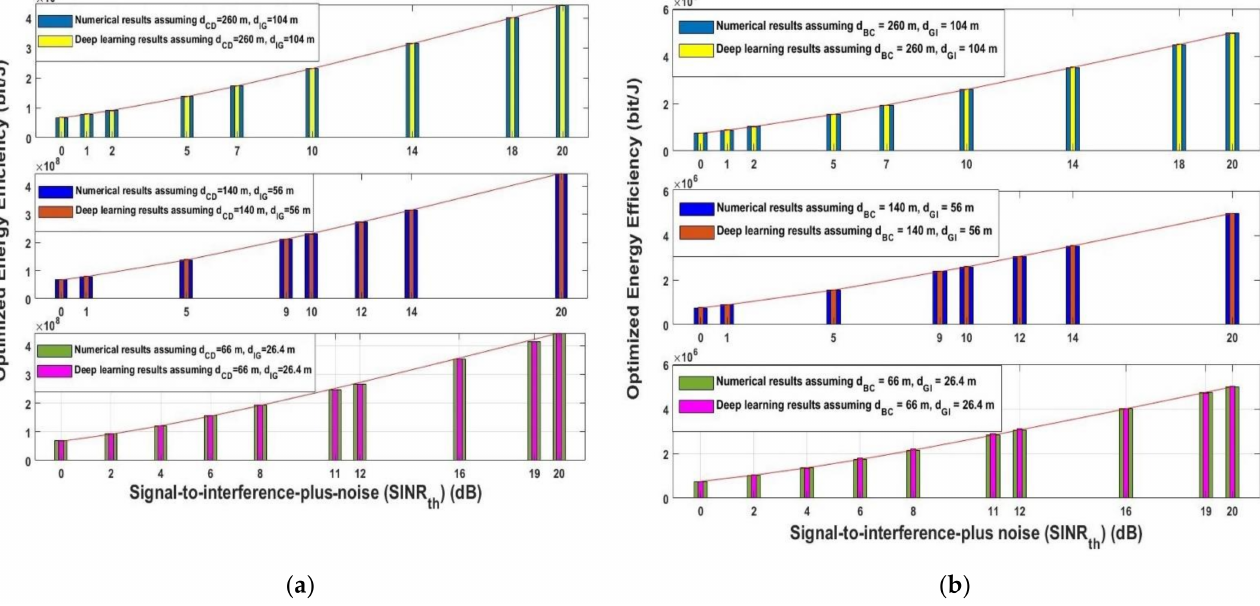
Figure 10. Signal-to-interference-ratio- plus-noise (SINR th ) versus optimized energy efficiency ( a ) uplink ( b ) downlink.